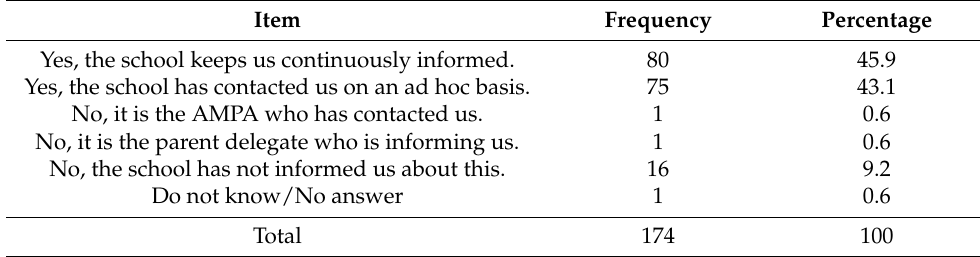
Table 2. Information received by families from the school. Item Frequency Percentage Yes, the school keeps us continuously informed. 80